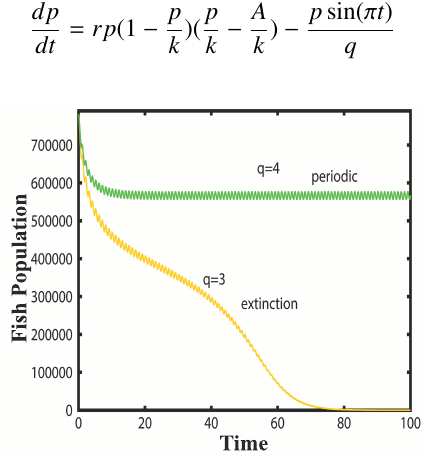
Figure 2. Periodic population and extinction with the di ff erent value of q